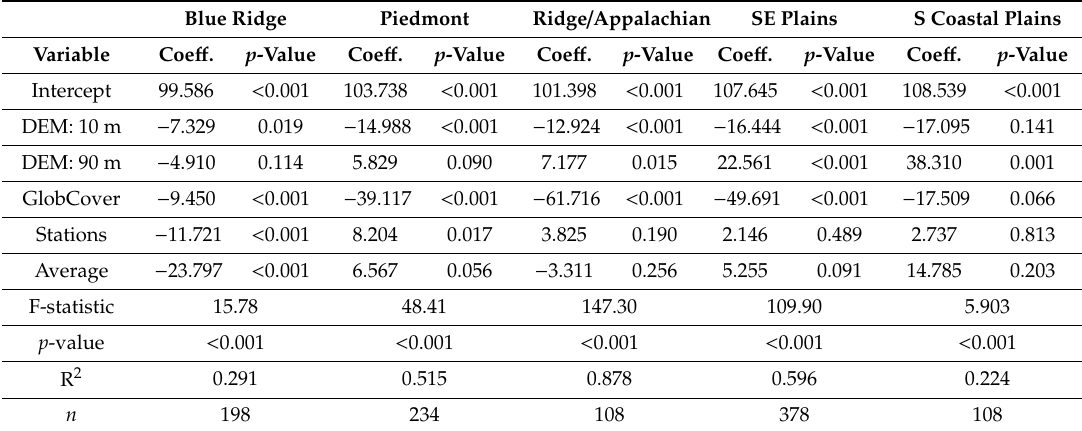
Table 6. Outputs of the multivariate linear regression models predicting the percentage change in phosphorus export (kg / ha / year) with respect to the Baseline Scenario for the five physiographical regions of Georgia using input spatial data as independent variables (digital elevation model (DEM), land cover and precipitation). Blue Ridge Piedmont Ridge / Appalachian SE Plains S Coastal